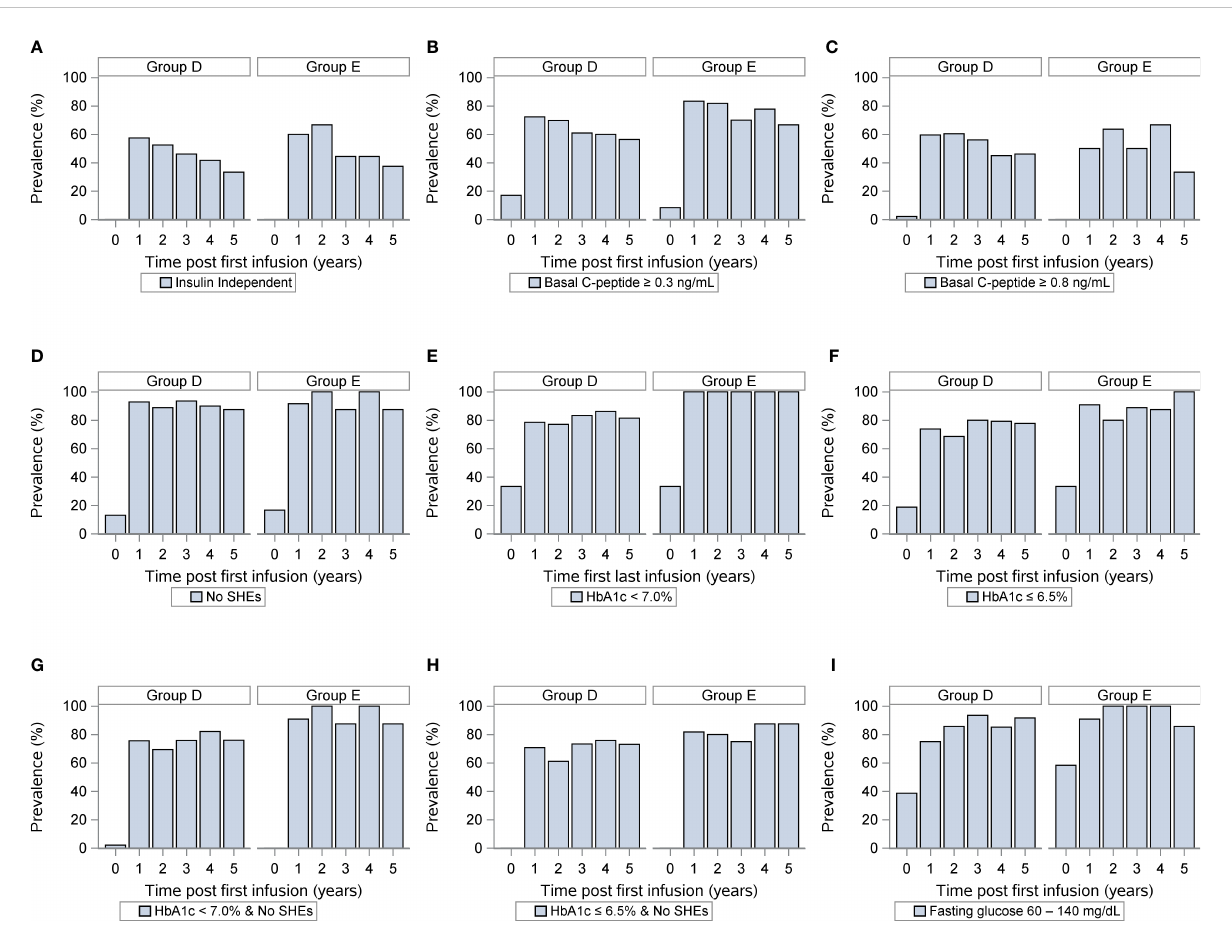
FIGURE 3 Outcomes of islet transplantation alone with complete HLA-A-B-DR data. Insulin independence (A) , basal C-peptide ≥ 0.3 ng/mL (B) , basal C- peptide ≥ 0.8 ng/mL (C) , absence of severe hypoglycemic events (D) , HbA1c <7% (E) , HbA1c ≤ 6.5% (F) , absence of severe hypoglycemic events and HbA1c < 7.0% (G) , absence of severe hypoglycemic events and HbA1c < 6.5% (H) , fasting blood glucose 60-140 (mg/dL) (I) in group D (<3 HLA A, B, DR matches) and group E (3-6 HLA matches). For each panel, the fi rst row indicates years after islet transplantation; the second the percentage with outcome; the third the number of individuals. P value comparing <3 Avg. Matches vs. ≥ 3 Avg.